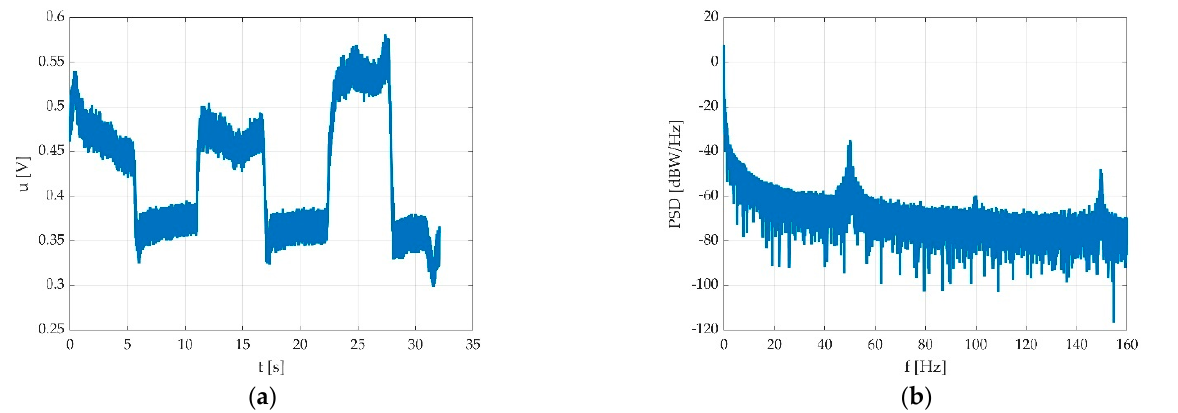
Figure 4. Typical pedal signal due to multiple consecutive flexions: ( a ) time graph with hum noise; ( b ) periodogram of power spectrum density (PSD).